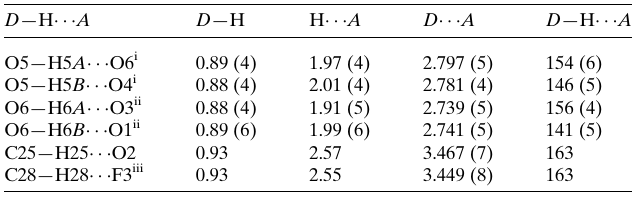
Table 1 Hydrogen-bond geometry (A˚ , (cid:3) ).